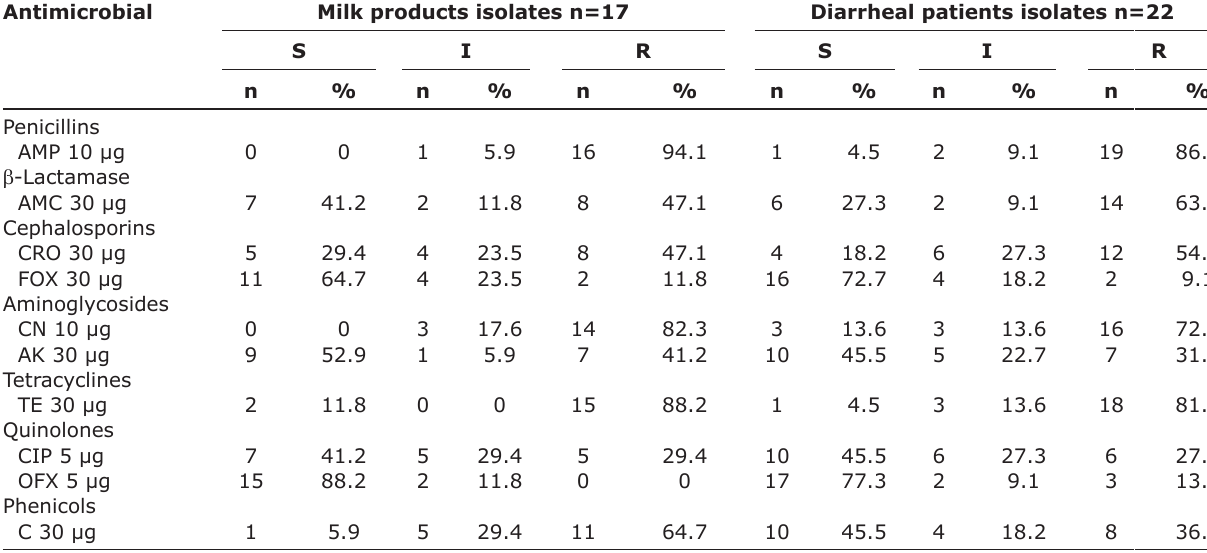
Table-3: Antimicrobial profile of E. coli O157:H7 isolated from milk products and diarrheal patients. Antimicrobial